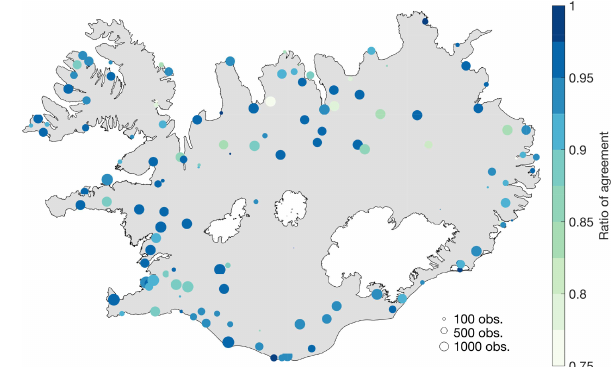
Figure 4. Comparison of observed snow cover and MODIS daily combined snow cover. For the whole data set the overall classifica- tion accuracy was